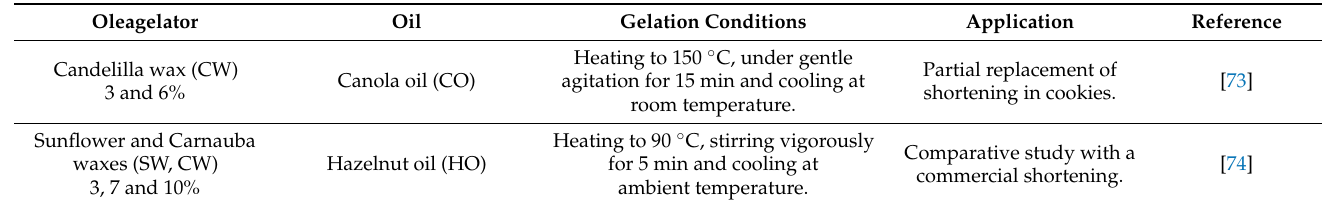
Table 1. Examples of oleogels obtained by direct dispersion